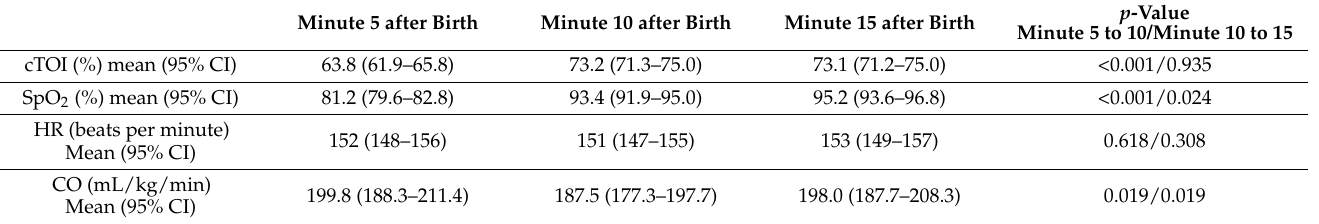
Table 2. Courses of vital parameters at 5, 10, and 15 min after birth.